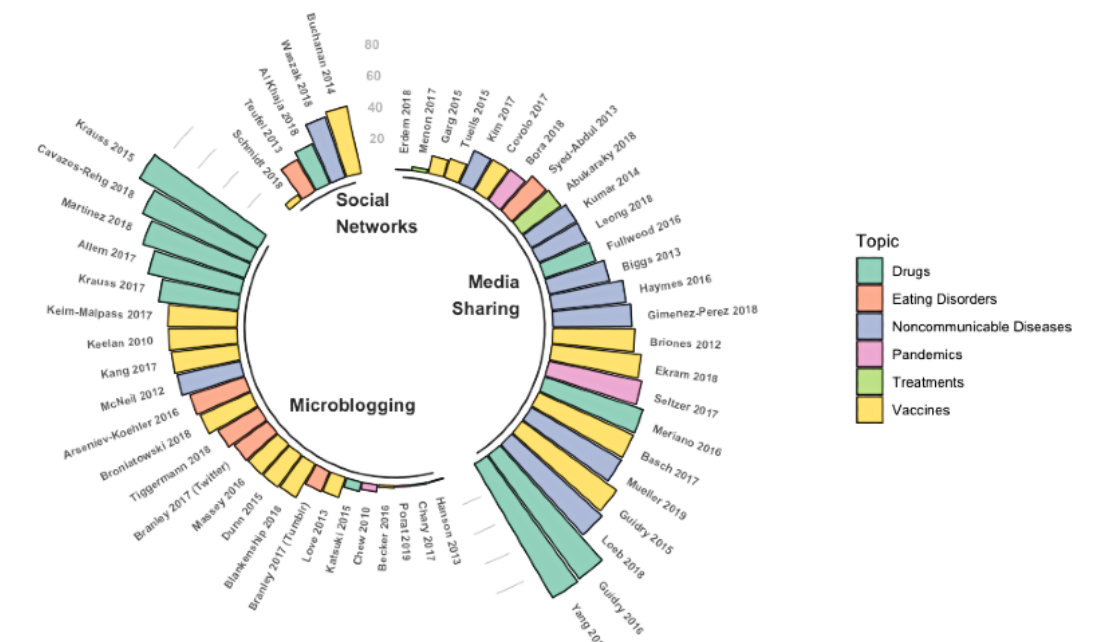
Figure 2. Prevalence of health misinformation grouped by different topics and social media type.